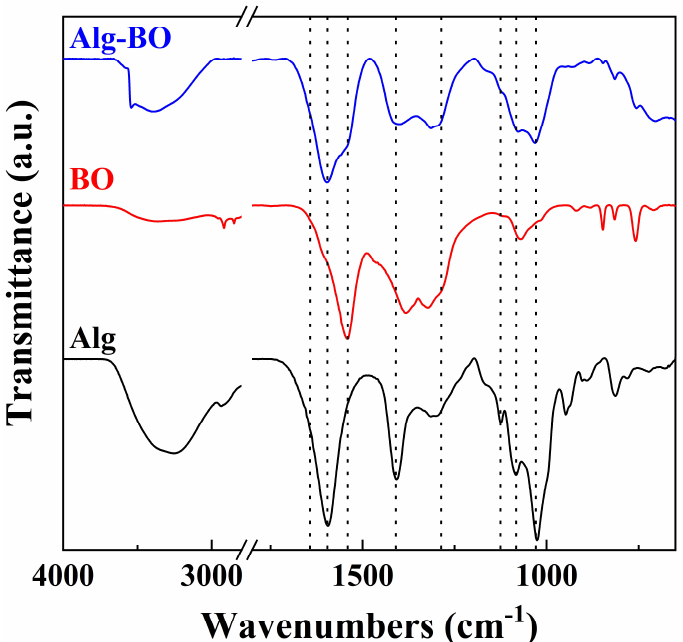
Figure 3. FT-IR spectra of Alg, BO, and Alg–BO (dotted lines: 1641, 1596, 1543, 1407, 1285, 1124, 1082, and 1025 cm −1 ).